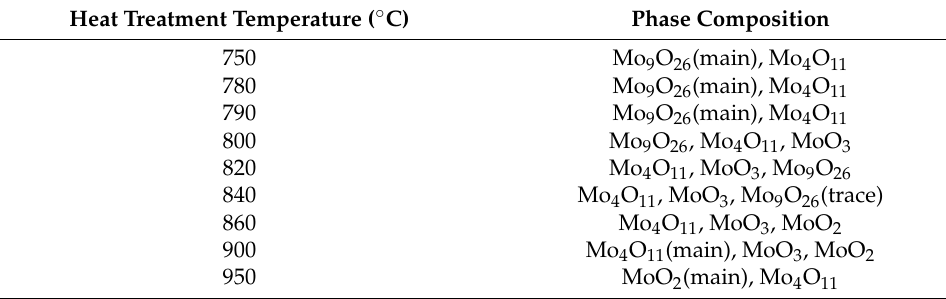
Table 2. Phase compositions of the Mo 4 O 11 powders after heat treatment.